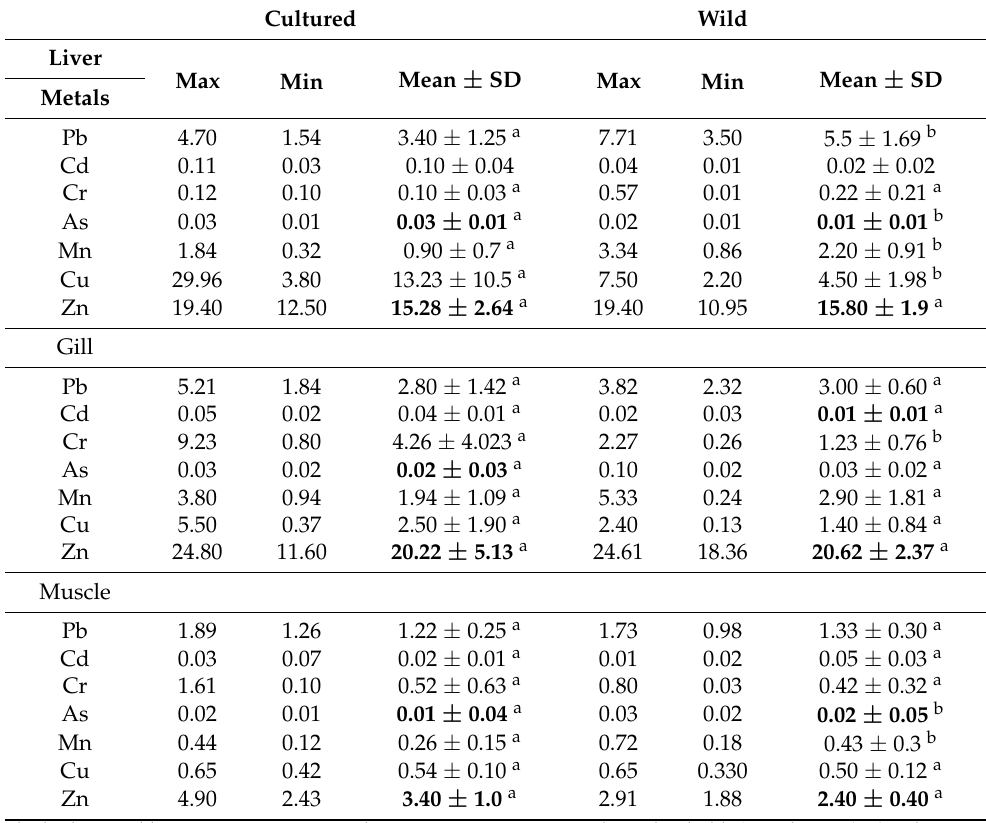
Table 1. Heavy metal concentrations (mg/kg wet wt) in the liver, gills and muscle of cultured and wild Barramundi fish.